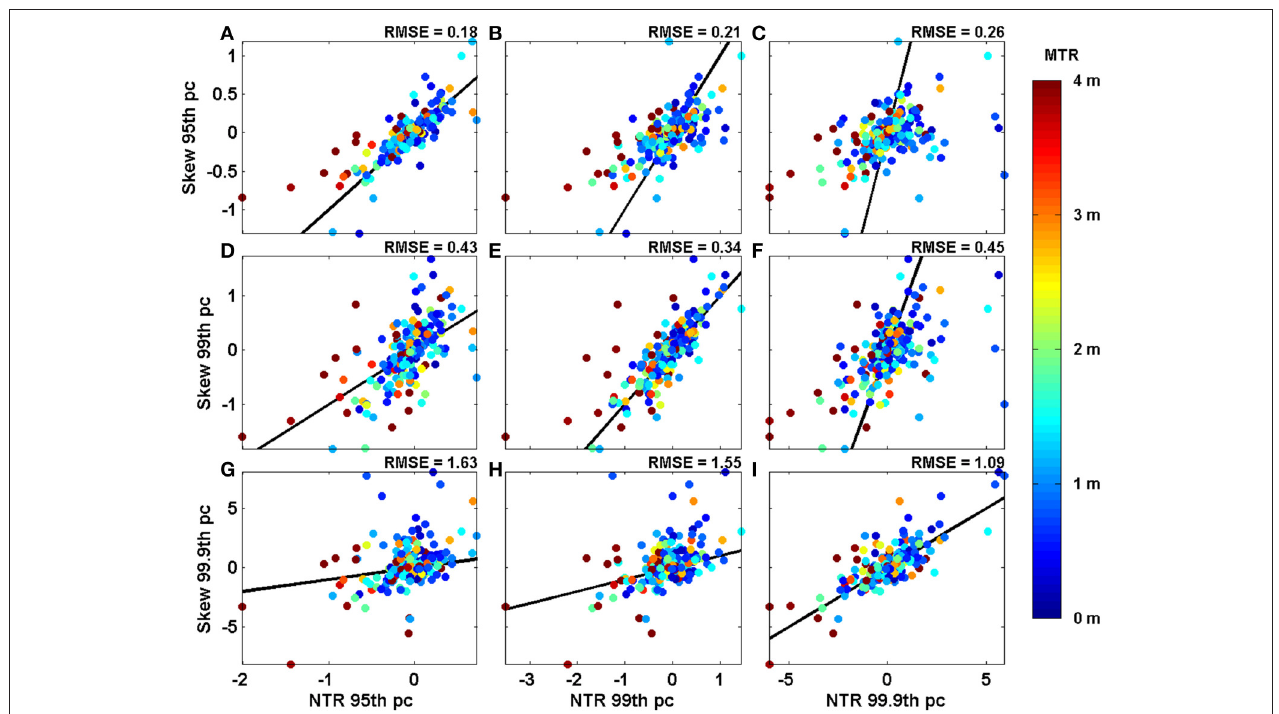
FIGURE 5 | Scatter plots comparing trends in the 95th, 99th and 99.9th percentiles and NTR (labeled along the x-axis), to the same percentiles of skew surge (labeled along the y-axis). Each point is shaded according to the average mean tidal range at each site. The black line shows 1:1 ratio. The root mean squared error value for each plot is the value for the best fit (red